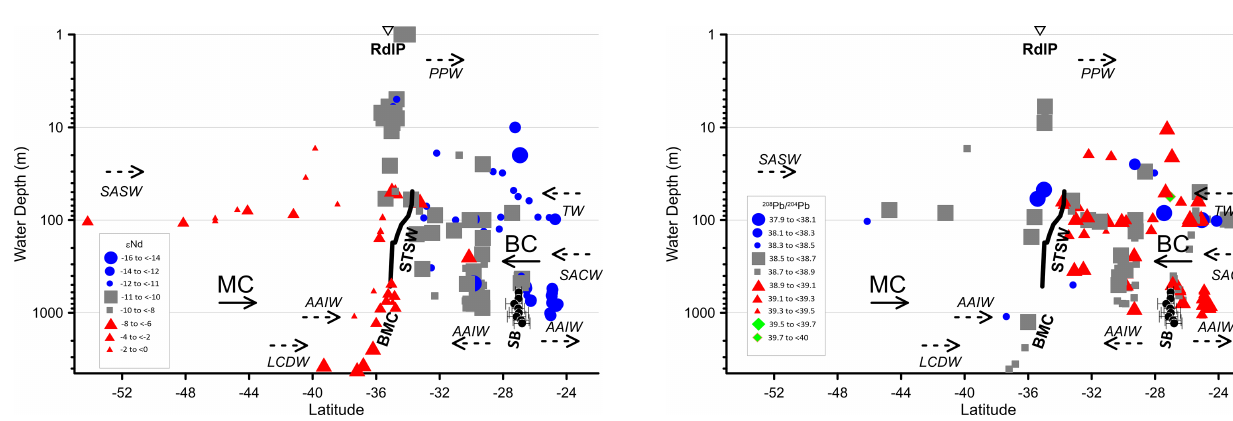
Figure 7. Latitudinal and bathymetric variability of ε Nd in the sector between 23 and 55 ◦ S. Water masses: Plata Plume Water (PPW), Subantarctic Shelf Water (SASW), Tropical Water (TW), South Atlantic Central Water (SACW), Antarctic Intermediate Wa- ter (AAIW), and Lower Circumpolar Deep Water (LCDW). Cur- rents: Malvinas Current (MC) and Brazil Current (BC). Fronts: Sub- tropical Shelf Front (STSW), Brazil–Malvinas Confluence (BMC), and Santos Bifurcation (SB). Vertical axis in log ( 10 ) scale.